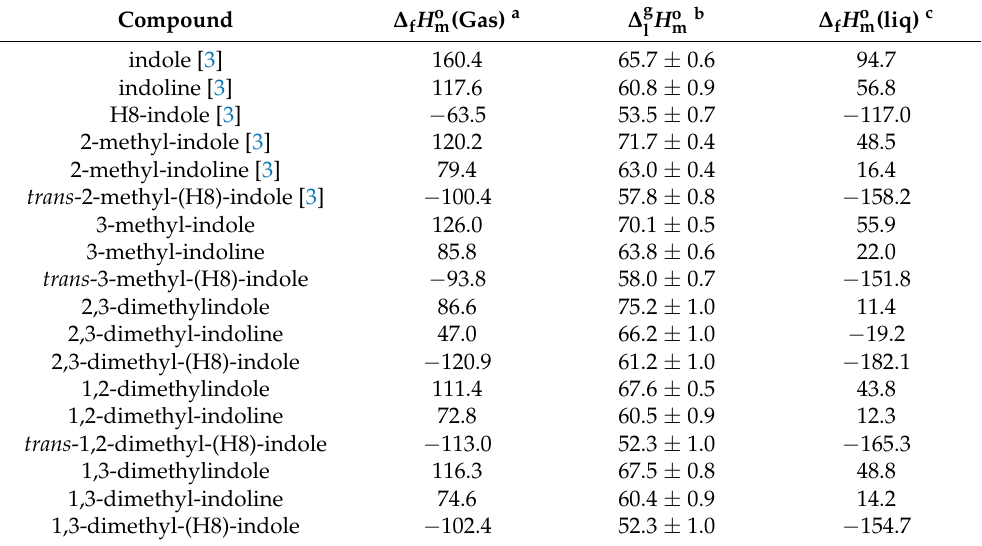
Table 8. Calculation of the liquid-phase enthalpies of formation, ∆ f H o m (liq), of the indole derivatives, at T = 298.15 K ( p ◦ = 0.1 MPa, in kJ · mol − 1 ).